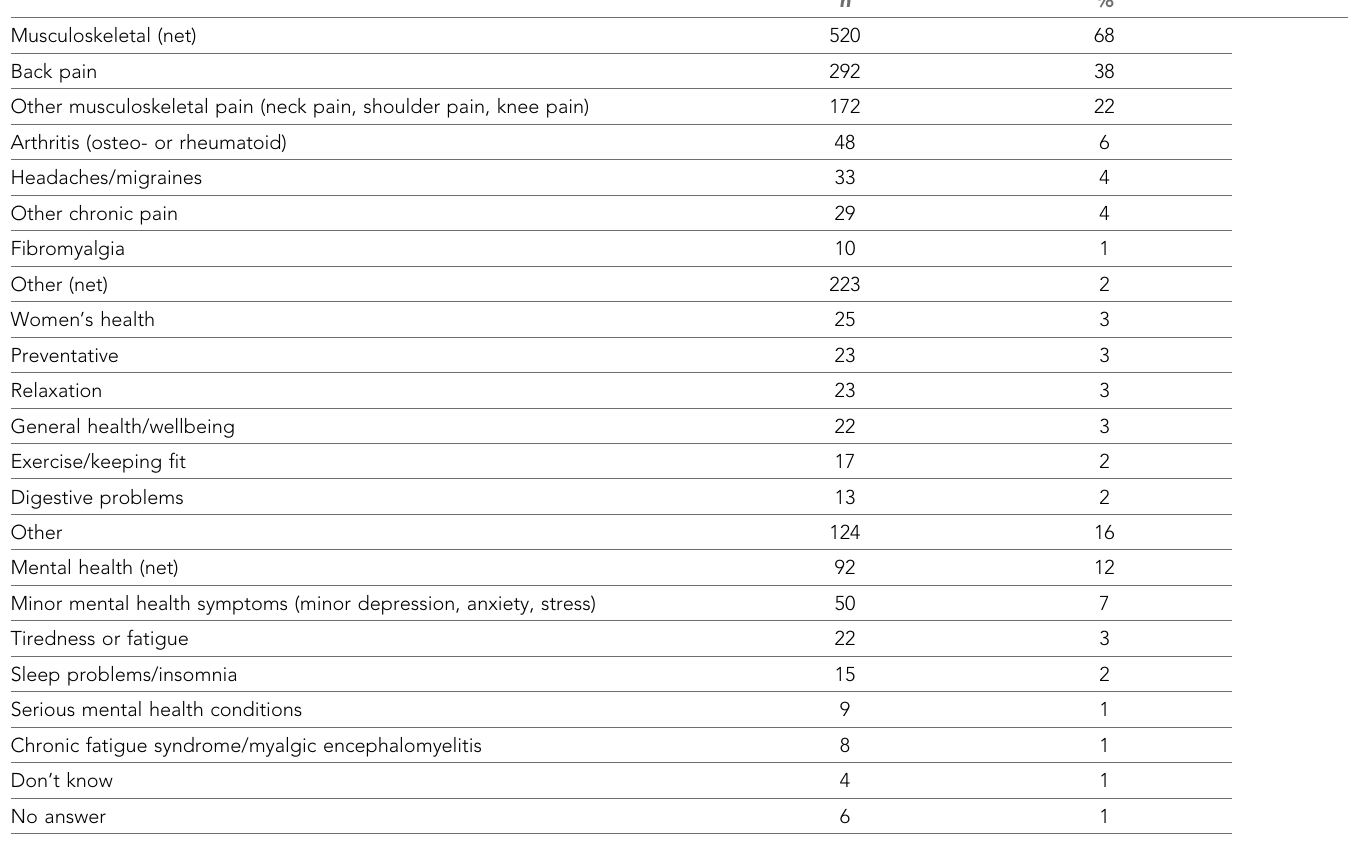
Table 4 Health conditions treated by a CAM practitioner ( n =